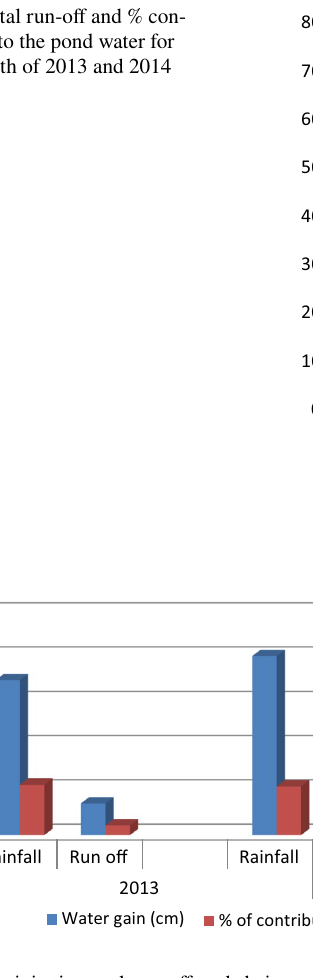
Fig. 3 Precipitation and run-off and their contribution in water gain percentage during 2013 and 2014